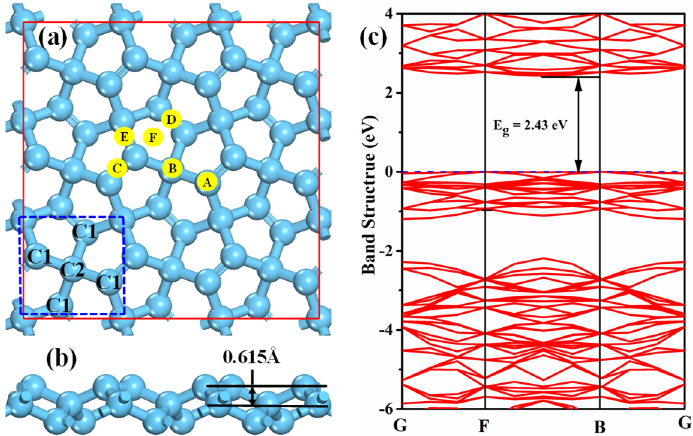
Figure 1. Top view ( a ), side view ( b ), and band structure ( c ) of pristine penta-graphene after full relaxation. The blue dashed square is the primitive cell, and the symbols of A ∼ F represent the possible adsorption sites. Table 1. The formation energy of penta-graphene with different dopants.